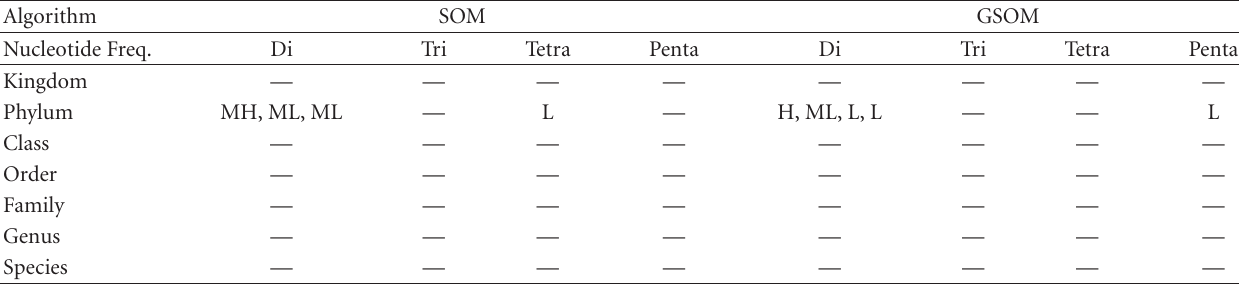
Table 4: Training results in the mixing regions for species Set 2.